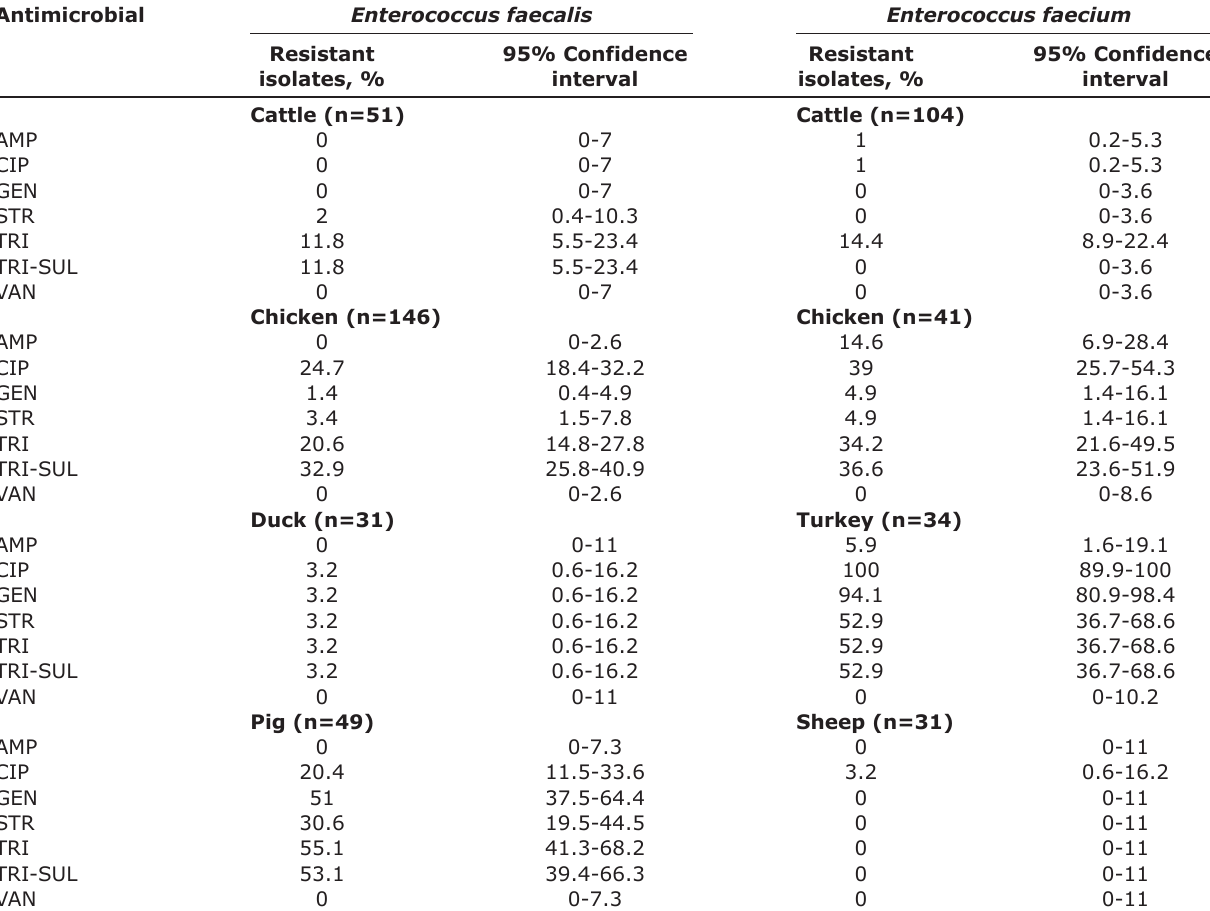
Table-3: Resistance patterns of enterococci isolates depending on the animal species (interpretation against EUCAST 2021).